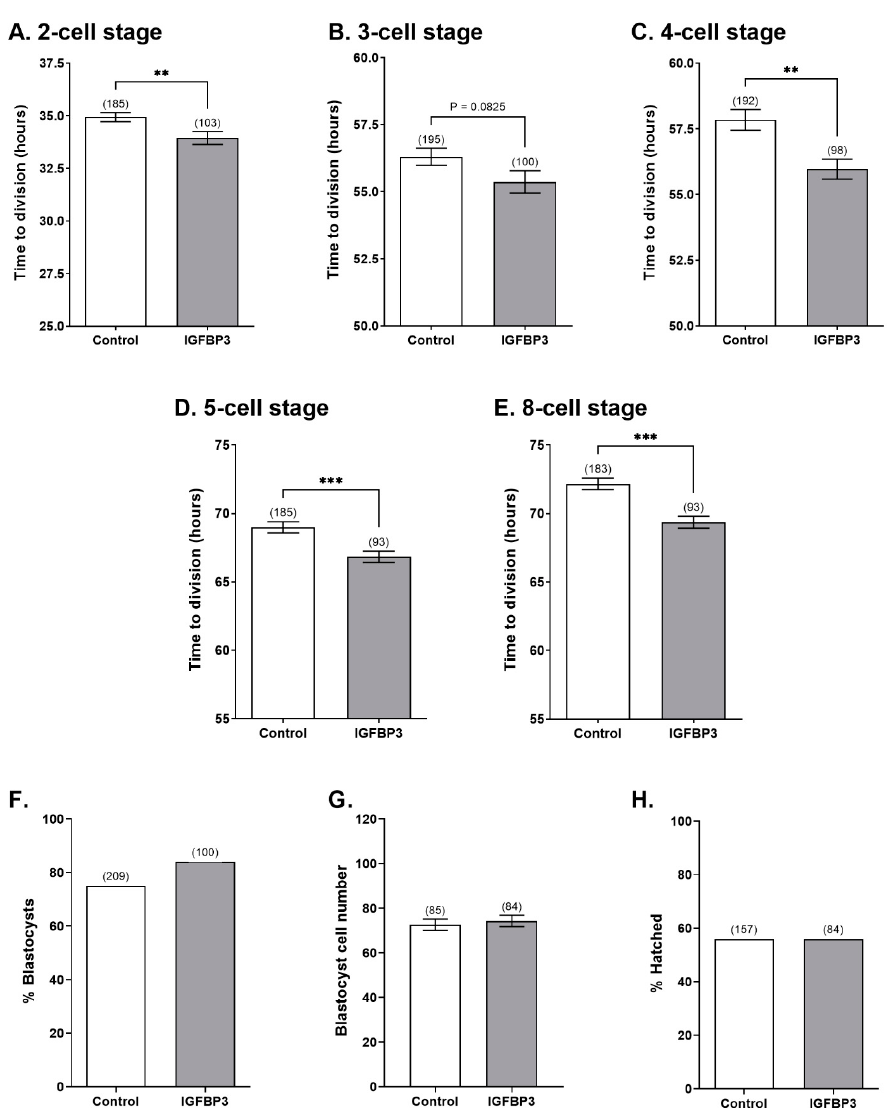
Figure 2. IGFBP3 decreases time to progress through the cell cycle. Mouse zygotes were isolated and cultured at a density of 1 embryo/100 µ L in the presence or absence of 100 ng/mL IGFBP3. Rate of development was measured using mean time taken, in hours post hCG injection, for the embryo to divide to the ( A ) 2-cell, ( B ) 3-cell, ( C ) 4-cell, ( D ) 5-cell, and ( E ) 8-cell stages ± SEM. Embryos that failed to develop to the blastocyst stage were excluded. Statistical analysis was performed by unpaired t -test. On day 6 of development, the percentage of embryos that developed to the blastocyst stage was recorded ( F ), and blastocysts were fixed and stained with DAPI to count the number of cells within each blastocyst ( G ). The percentage of blastocysts that hatched from the zona pellucida ( H ) was also recorded. The percentage of embryos that reached the blastocyst and hatched blastocyst stages in control and IGFBP3 treatments were compared using a chi-squared test. Average cell numbers between control and IGFBP3 treatments were compared using an unpaired t -test. Data shown represent 6–11 independent experiments (number of embryos are in parentheses). ** = p < 0.01, *** = p <